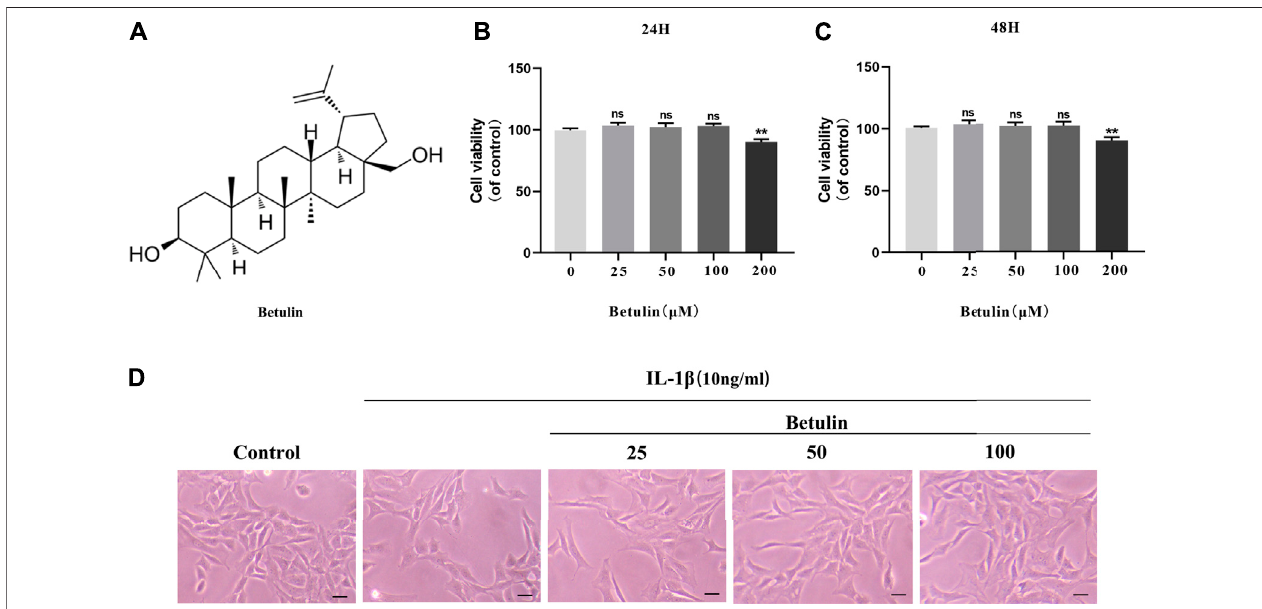
FIGURE 1 | Effect of betulin on the viability of OA chondrocytes. (A) The chemical structure of betulin. (B – C) The cell was cultured with betulin (0, 25, 50, 100, and 200 μ M) different concentrations for 24 and 48 h, and the cell viability was measured using the CCK-8 kit. (D) After the chondrocytes were pretreated with different concentrations of betulin, the chondrocytes were imaged with a phase contrast microscope (scale bar: 50 μ m). The data in the fi gure represent the average ± SD, ** p < 0.01 compared to the control group, n (cid:2)